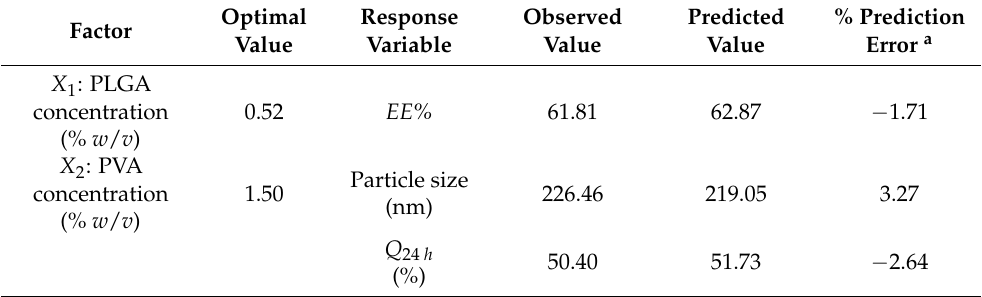
Table 4. Composition, observed and predicted responses of the optimum NFD-CTS-PLGA nano- composites.